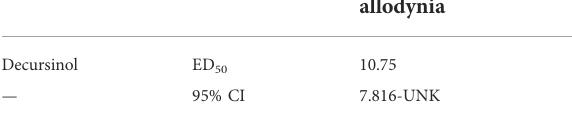
TABLE 3 Calculated ED 50 value (mg/kg) assessing the anti-allodynic effect of decursinol in neuropathic mice. The ED 50 value was calculated from a dose-response curve generated using non-linear regression analysis. The value shown is the mean ED 50 dose and 95% con fi dence interval for decursinol in neuropathic mice (N = 30). UNK = value(s) that could not be calculated.